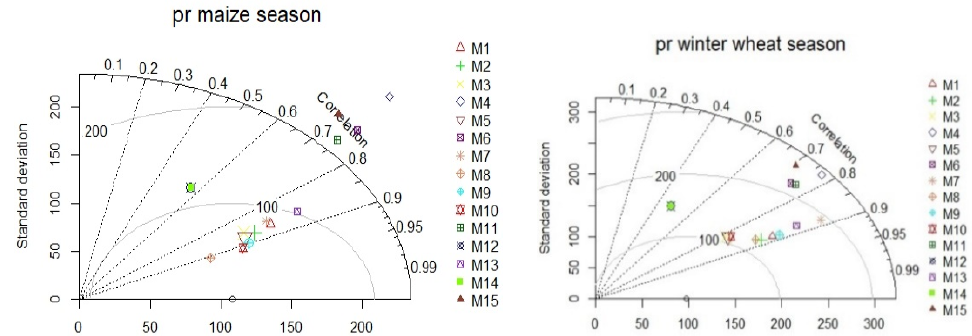
Figure 7. Validation of pr in 15 EURO-CORDEX simulations against ROCADA observation-derived data, over the period 1971–2000 (full names of individual models are given in Table 1) for vegetation periods of maize (April–October) and winter wheat (October–June). In the diagram, the circle on Ox-axis represents the observation, and the colored plots represent the different models. Three statistics determine the relative places of the models: the Pearson correlation coefficient (curved axes), the centered RMS error (grey contours), and the standard deviation (Oy-axis). The model best fitting with observations will lie the nearest to the Ox-axis.